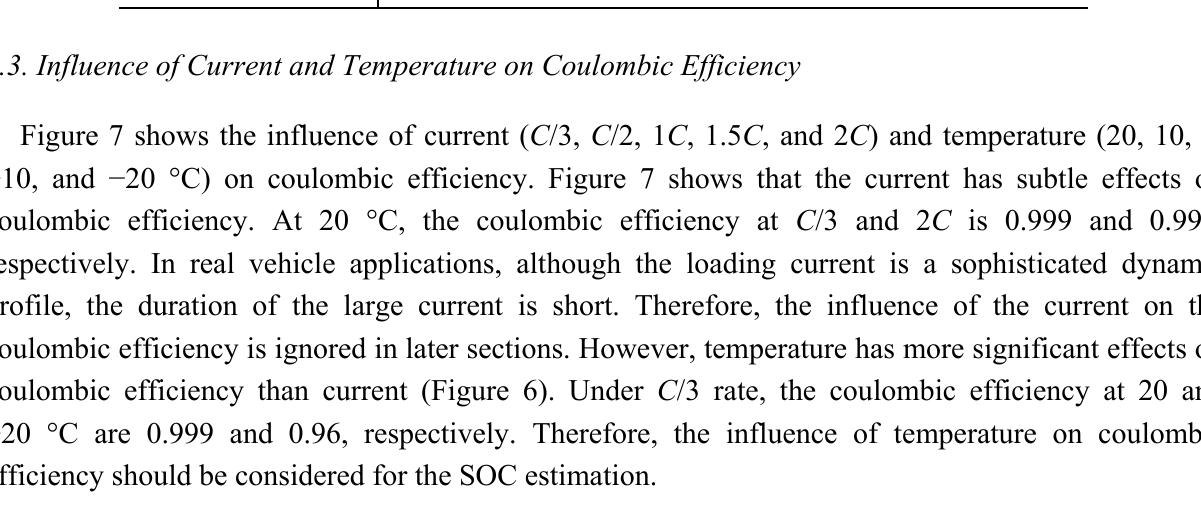
Figure 7. Influence of current and temperature on coulombic